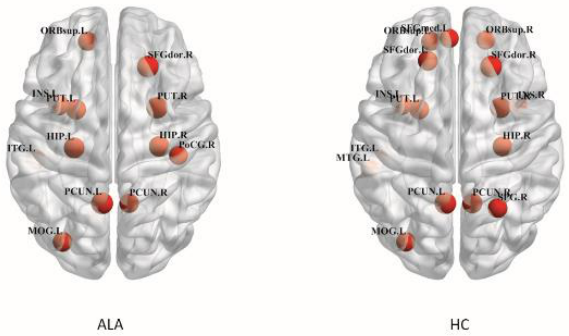
Figure 3. The distribution of hub regions in participants in the HC and ALA groups. HC: healthy control; ALA: asymptomatic subject with leukoaraiosis. The figure was processed using BrainNet Viewer software. “R” and “L” indicate the right and left sides, respectively. SFGdor: superior frontal gyrus, dorsolateral; SFGmed: superior frontal gyrus, medial; ORB.sup: superior frontal gyrus, medial orbital; INS: insula; PUT: putamen; HIP: hippocampus; ITG: inferior temporal gyrus; PoCG: postcentral gyrus; PCUN: precuneus; MOG: middle occipital gyrus; MTG: middle temporal gyrus; SPG: superior parietal gyrus.